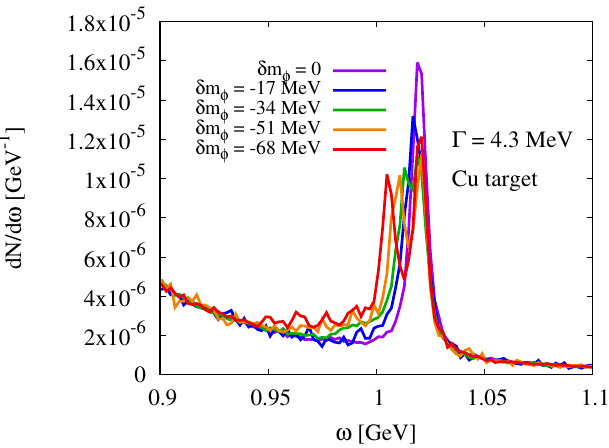
Figure 1. The di-lepton spectra in the ϕ meson mass region, obtained in simulations of 12 GeV pCu reactions for scenarios of di ff erent negative mass shift magnitudes for the ϕ meson at fi nite